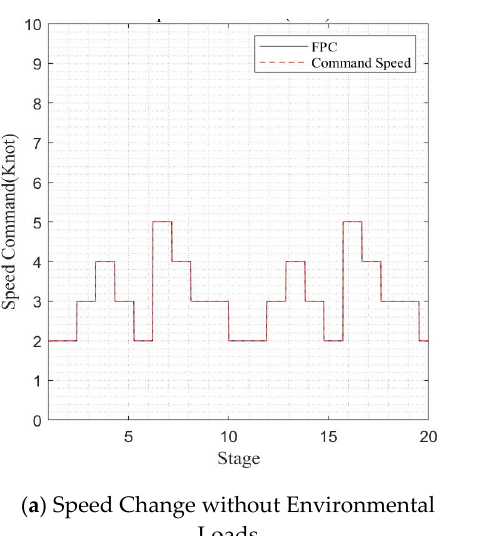
Figure 8. Speed change according to speed control method.